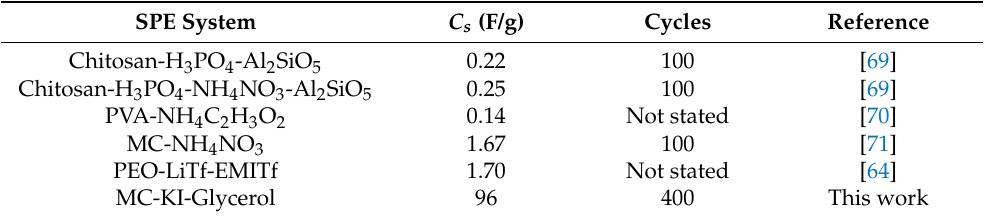
Table 4. Proton-based EDLC studies with their relative specific capacitance value. SPE System C s (F/g)